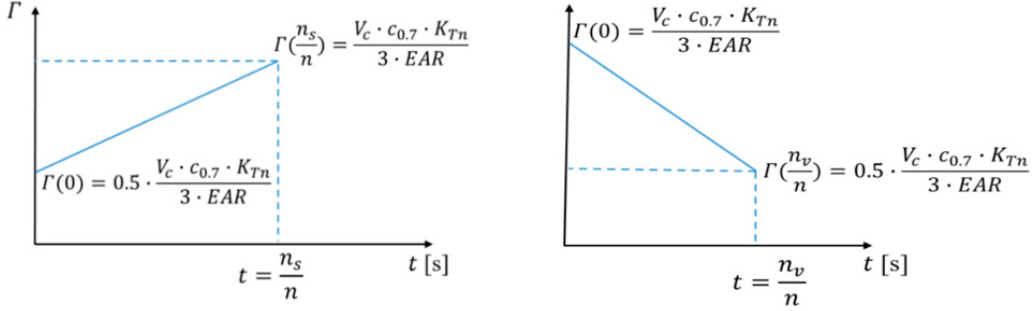
Figure 7. Propeller circulation as a function of time to establish the vortex ventilation (top side) and as a function of time for ventilation to dissapear (bottom side), K Tn is the thrust coe ffi cient for non ventilating condition and K T is the thrust coe ffi cient for ventilating condition for given and constant propeller submergence h / R .